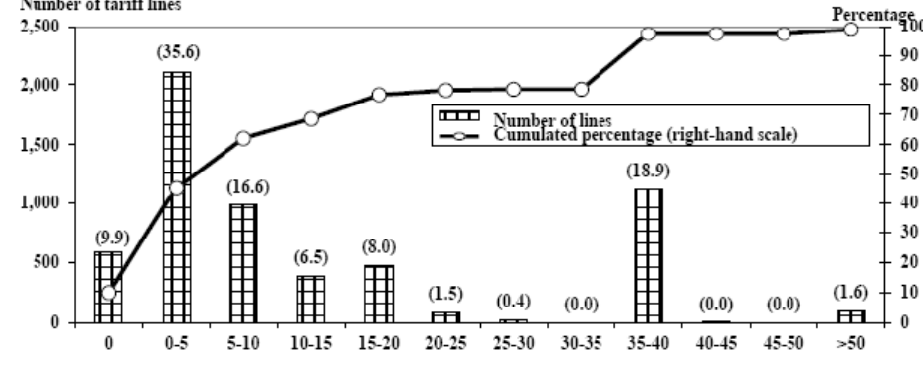
Fig. 1 Breakdown of Zimbabwe’s applied MFN tariff rates in 2011 Source: Adapted from the World Trade Organization 2011 Report on